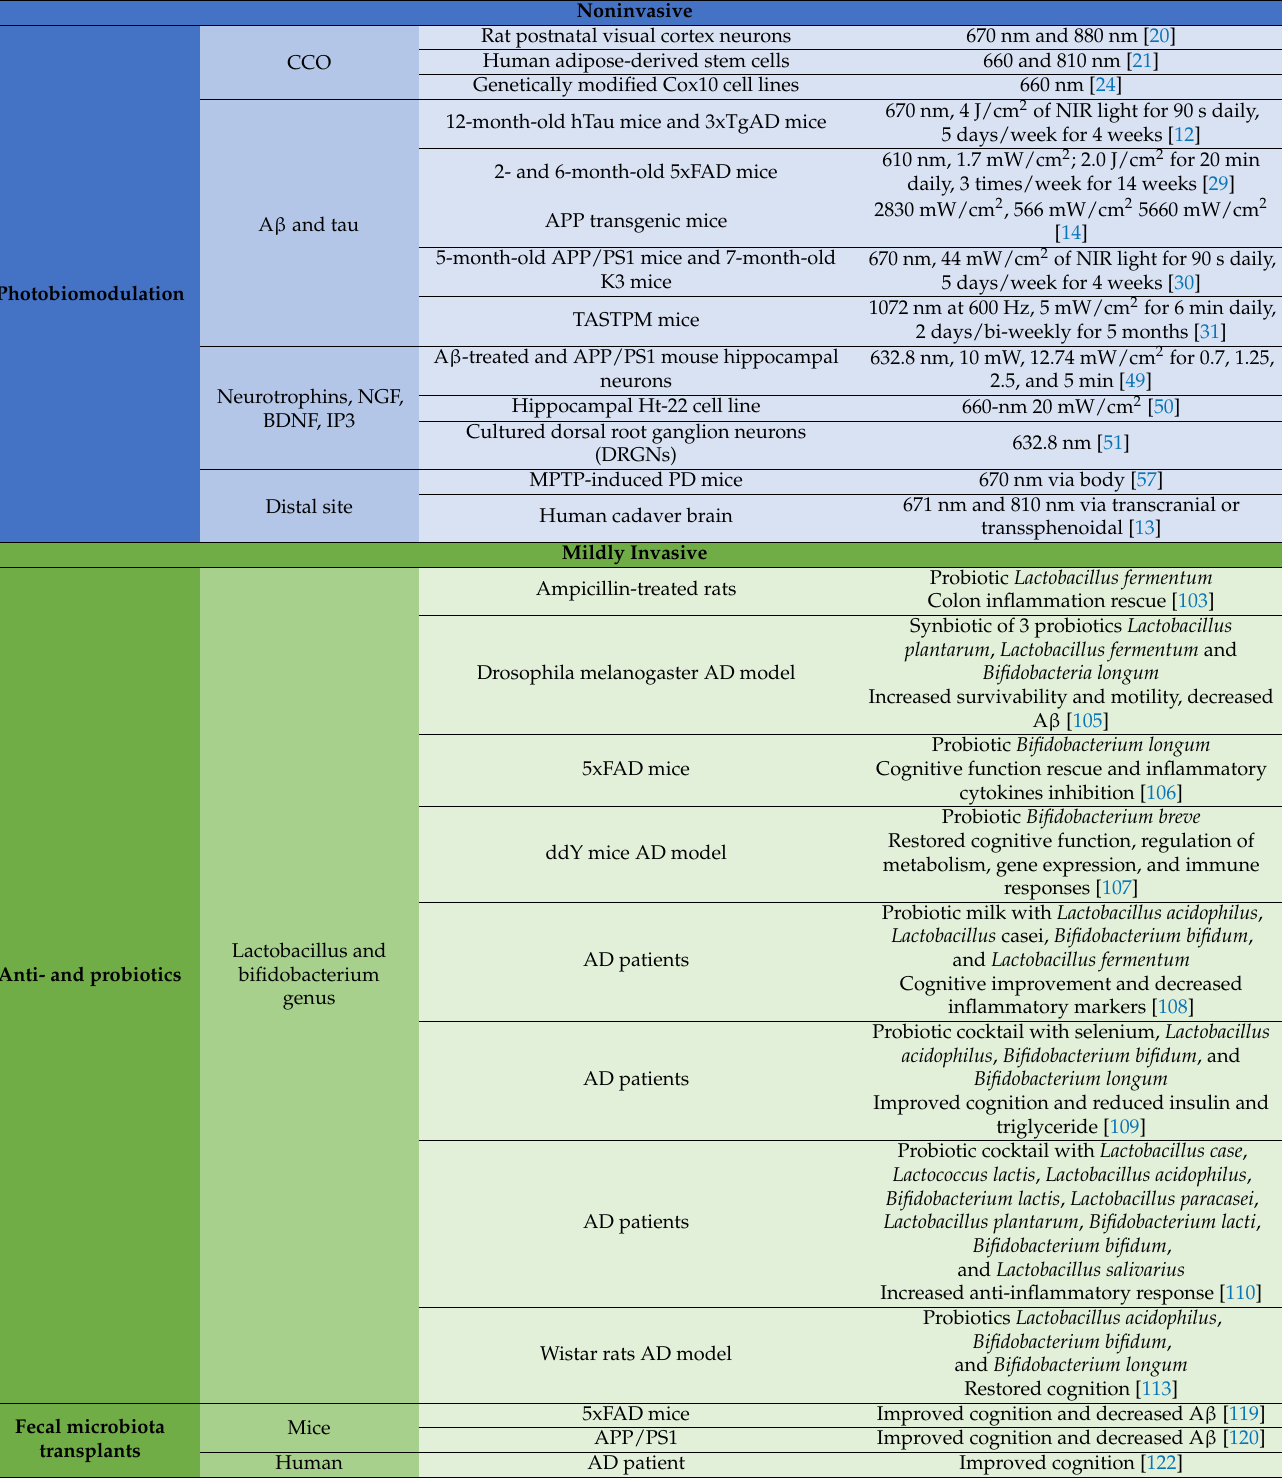
Table 1. A summary of the three different non-pharmacological therapeutic intervention avenues that have been studied for the treatment of Alzheimer’s